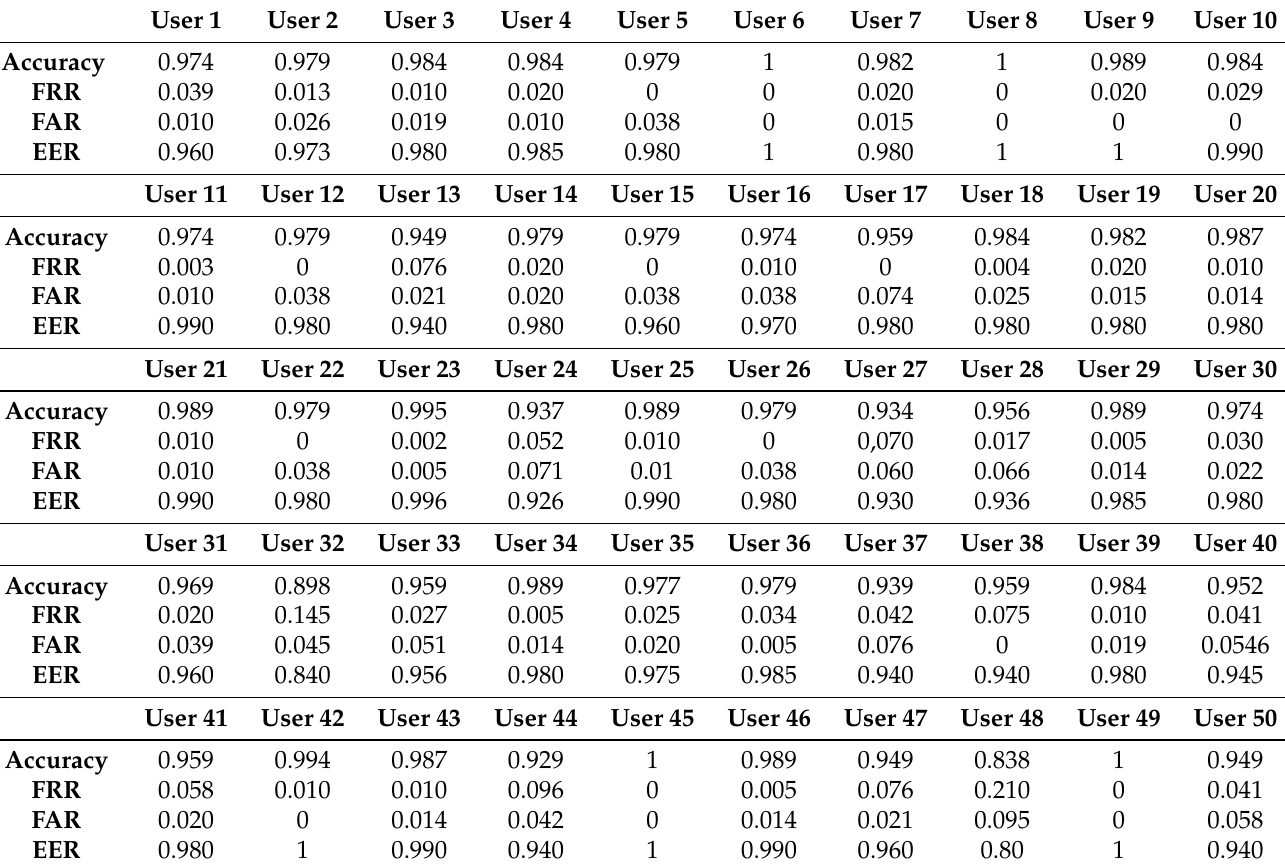
Figure 13. The accuracy distribution statistics of these 50 experiments are shown in Table 6, from which it can be obtained that more than 50% of the accuracy is distributed in the range of 95–97%, and even four times the accuracy reaches 100%, which may be due to the small amount of data for these users.The average accuracy of these 50 experiments was 97.1% Table 5. The authentication performance of the model on these 50 datasets.